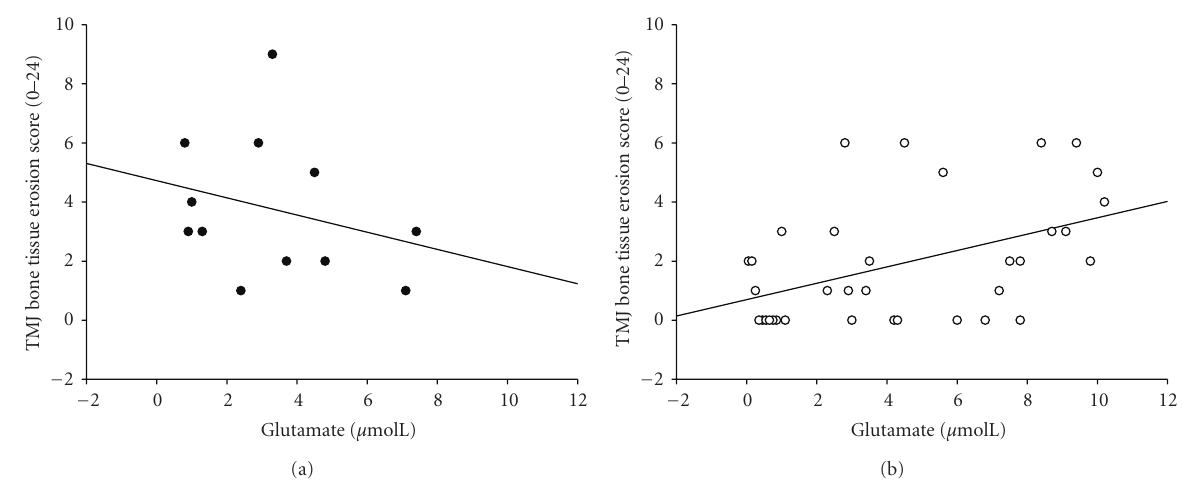
Figure 1: Scatter plots showing (a) the relationship between plasma level of glutamate and temporomandibular joint (TMJ) bone erosion score in the patients with crepitus ( r s = − 0 . 35, n = 12, P = . 253) and (b) in the patients with no crepitus ( r s = 0 . 45, n = 35, P = . 007). • : crepitus, ◦ : no